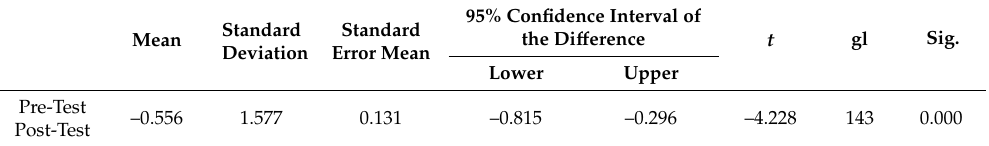
Table 6. t -student test for related samples of pre-test and post-test data in First